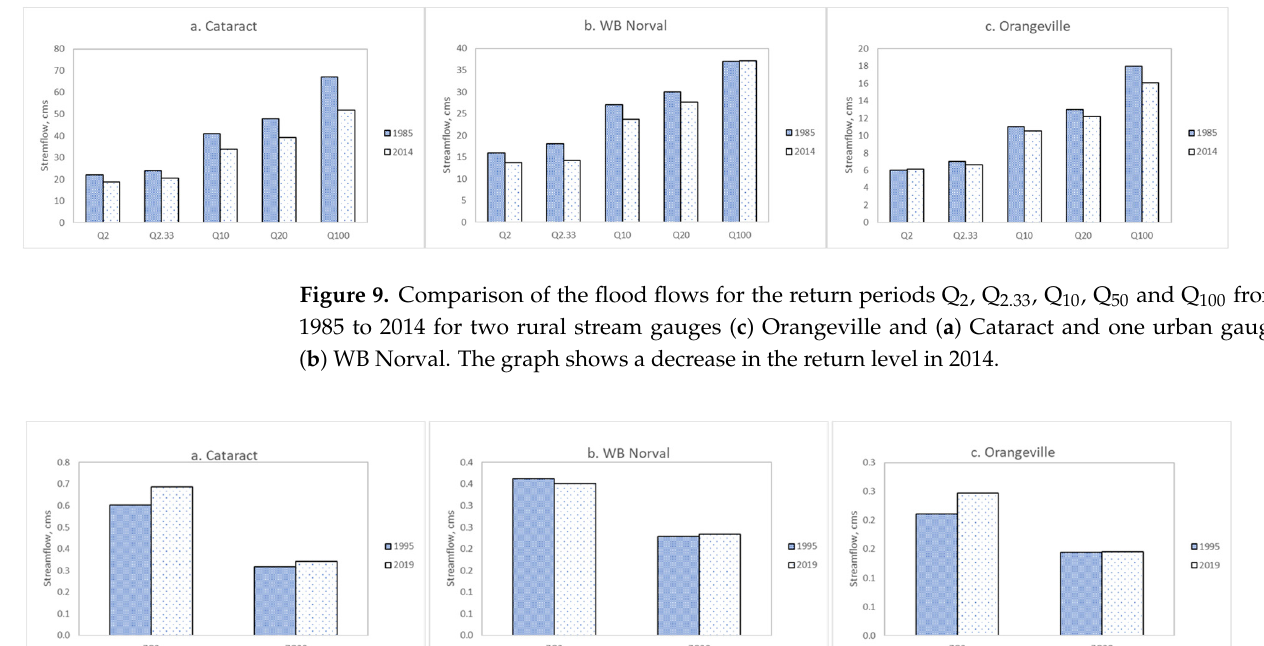
Table 6. Table showing the land cover percentage for the years 1956 (published data [24]), 1996[24]